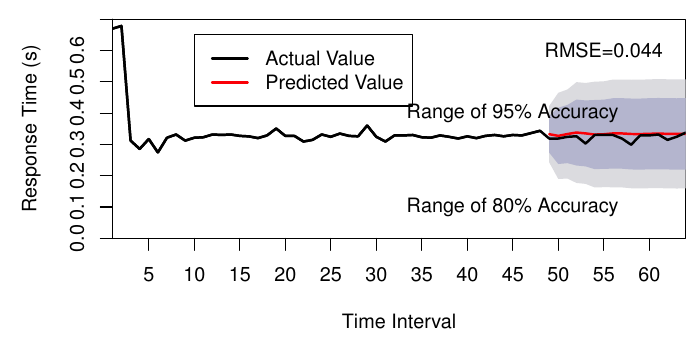
Figure 7. Forecasting of QoS Series. RMSE: root-mean-square error.